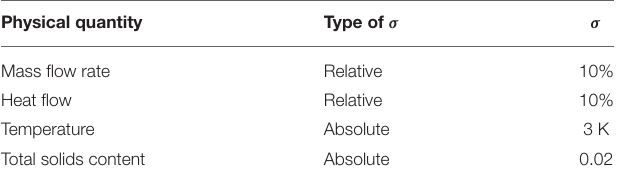
TABLE 1 | Nominal uncertainty